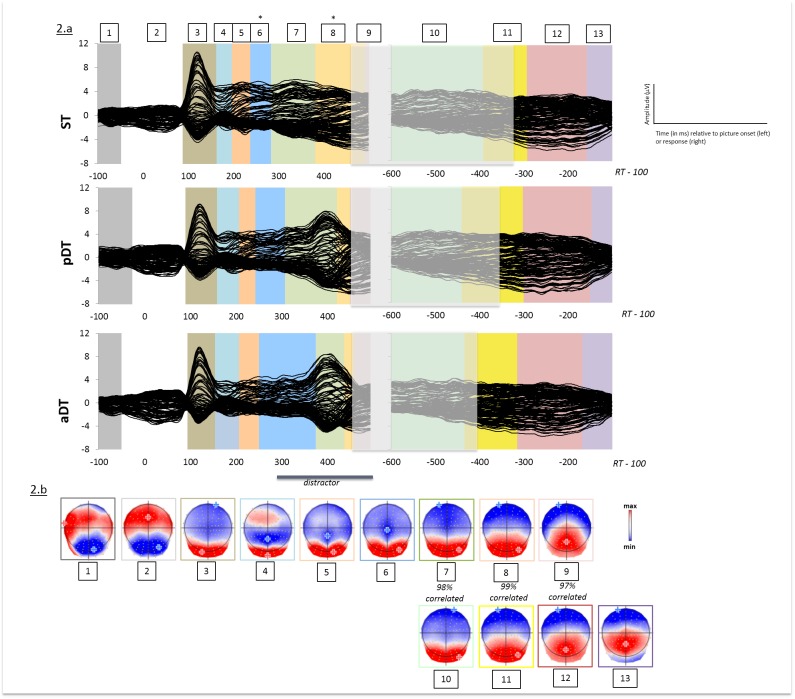
(a) Grand-average ERPs (128 electrodes) for each task (Single task ST, passive dual-task pDT and active dual-task aDT) when distractors were tones from 100 ms prior to picture onset to 100 ms before the verbal response and temporal distribution of the topographic patterns revealed by the spatio-temporal segmentation analysis. Stable electrophysiological configurations are color-coded. The white shaded area illustrates overlap between stimulus-aligned and response-aligned data as a function of grand-averaged production latencies for each task. (b) Map templates for the nine stable topographies observed from 100 ms prior to picture onset to RT-100. Positive (red) and negative (blue) values are displayed as well as maximal and minimal scalp field potentials. Correlations between map templates 7, 8, 9 and 10, 11 and 12 respectively are indicated. * indicate significant differences (p < 0.05) observed on any specific topographic pattern contrasting ST, pDT and aDT.